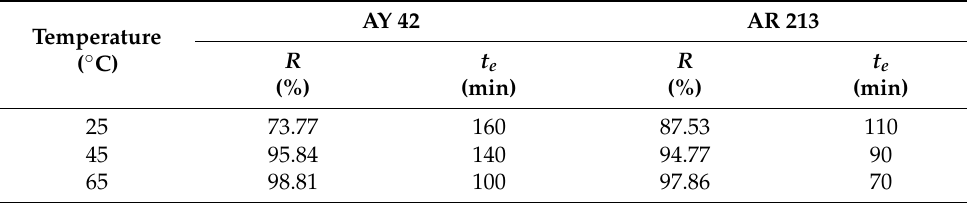
Table 7. Influence of temperature on the adsorption capacity of